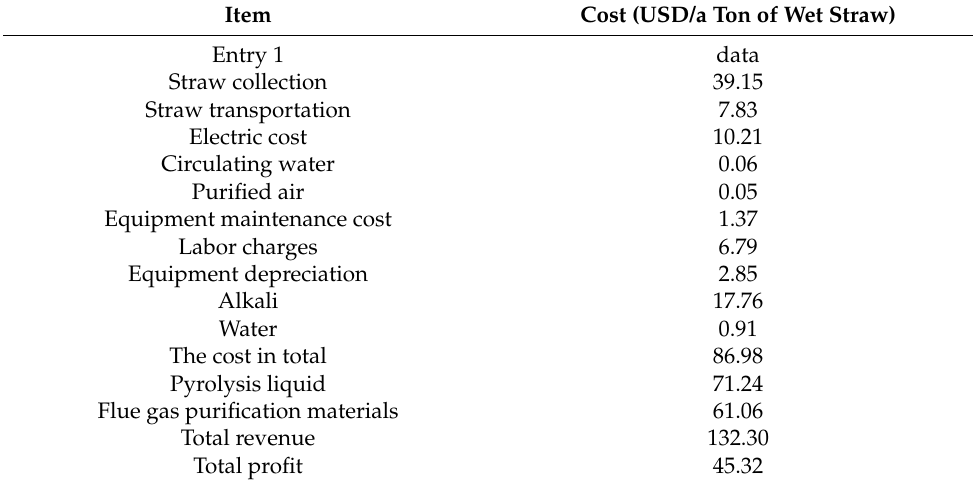
Table 1. Cost table for the non-phase-transition drying pyrolysis and mass conversion technology.